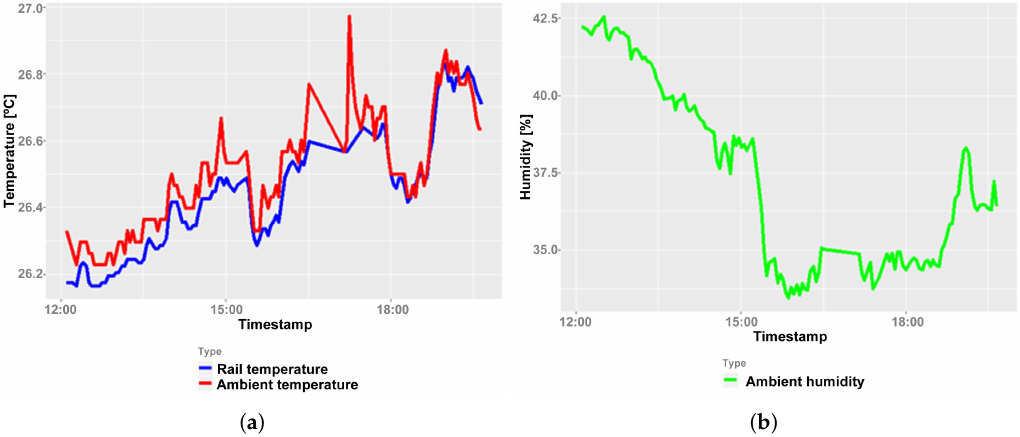
Figure 11. Examples of collected actual environmental data extracted from MIMOSA: ( a ) Temperatures and ( b )